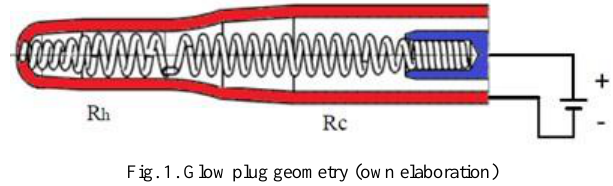
Fig. 1. Glow plug geometry (own